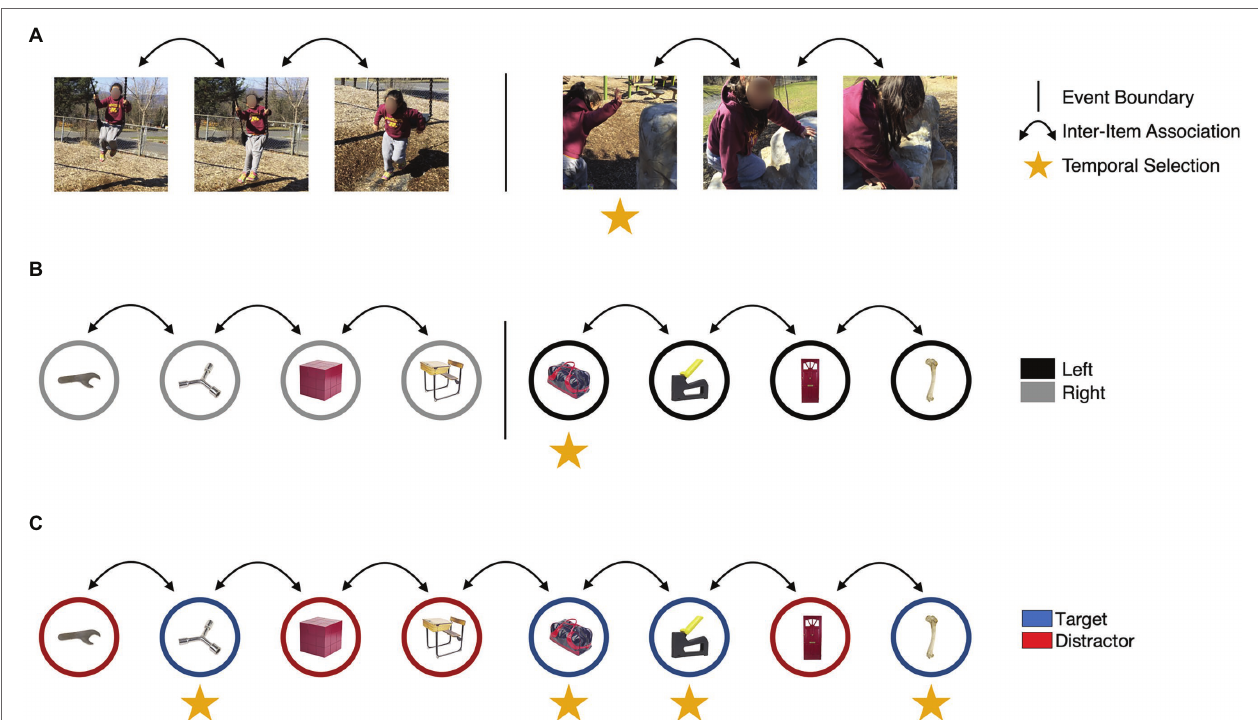
FIGURE 3 | The ABE may capture some, but not all, of the mechanisms that guide attention and memory for everyday events. (A) During naturalistic experiences, changes in location, goals, or behavior may cause events to be segmented (Zacks et al., 2010), as indicated by the vertical bar. Event segmentation may disrupt context representations and lead to the establishment of new event models to guide cognition and behavior. This process could reduce the accessibility of perceptual and conceptual features of items encountered before the change (i.e., the color of the swing) and enhance the encoding of items that were on the screen during an event boundary, as indicated by the vertical arrows. (B) In laboratory studies, event boundaries may be evoked by changing task instructions during an encoding task. In this task modeled on Clewett et al. (2020), a tone is played into one ear each time an object is presented. If the tone is played in the left ear, participants respond to a judgement task (e.g., is this object more likely to be found inside or outside?) using their left hand. If the tone is played in the right ear, participants respond with their right hand. A continuous train of items paired with right-side tones followed by a left-side tone results in a boundary and creates a break in the temporal associations between items. (C) In the ABE, items presented concurrently with targets are enhanced. However, there is no evidence that target detection disrupts temporal context representations or that it influences the formation of inter-item associations. Image attributions: As in Figure 1 , additionally, video stills reproduced with permission from Khena Swallow taken from her personal